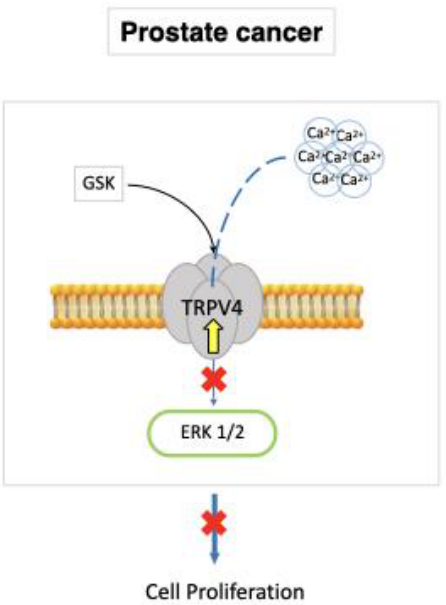
Figure 3. TRPV4 is up-regulated in A-TECs. Pharmacological GSK stimulation of TRPV4 restores mechanosensitivity to ECM rigidity, blocks the ERK1/2 pathway, and reduces the rate of A-TEC proliferation.